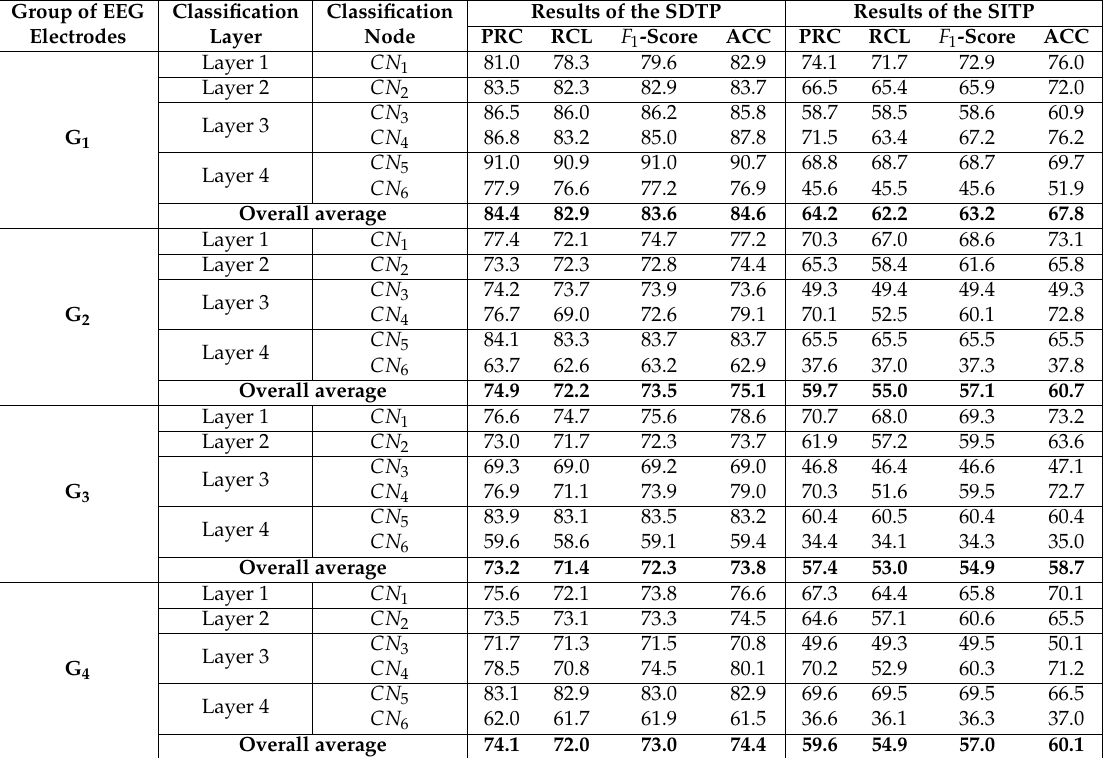
Table 3. Results of the channel-based analysis obtained using the SDTP and SITP for the intact subjects in DB 1 . The set of EEG electrodes comprised in each group is provided in Table 2. Group of